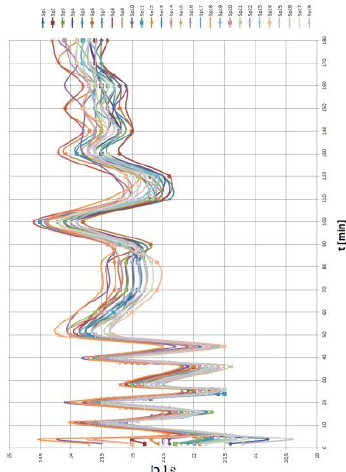
Fig.2 . Temperature of the lateral surface of gauge block after being touched by a hand. In time t = 0, the plate ( czy płytki wzorcowej - wó wczas gauge block) was placed in a climate